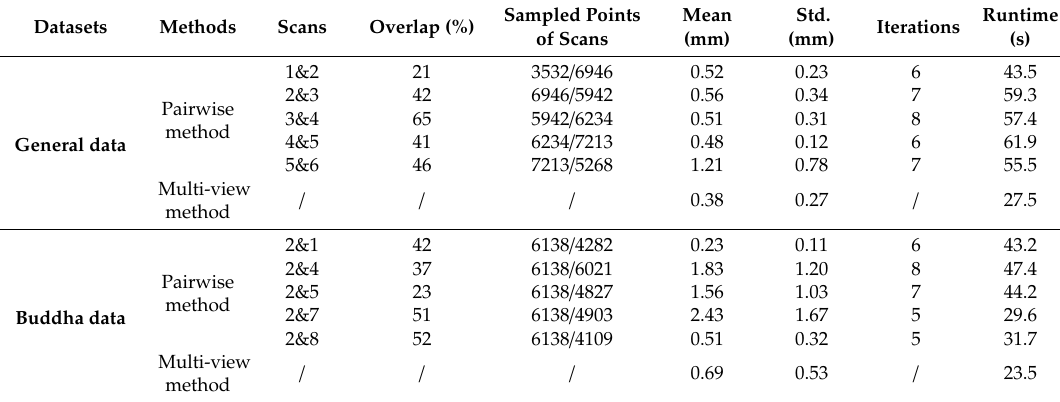
Figure 12. Pairwise registration results of General and Buddha data: ( a ) General data: scan 1&2, scan 2&3, scan 3&4, scan 4&5, scan 5&6, ( b ) Buddha data: scan 2&1, scan 2&4, scan 2&5, scan 2&7, scan 2&8, respectively. Table 1. Evaluation of registration